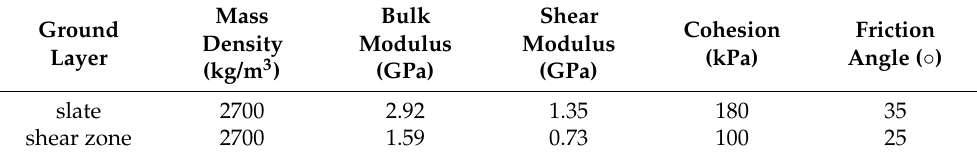
Figure 15. The slope model of profile X-X’, with the ground layers of rock material (slate) and shear zone. Location of the ground water table is also indicated.